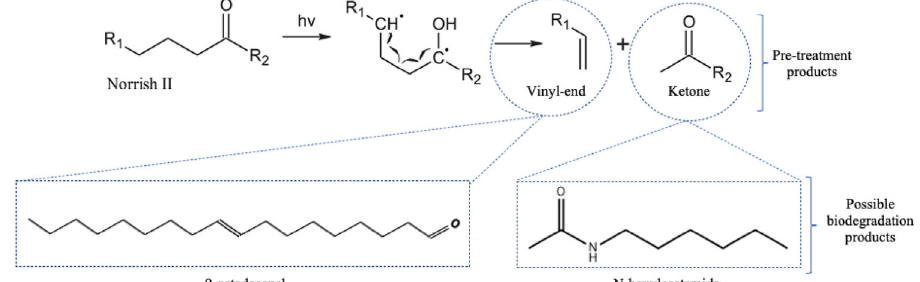
Fig. 4 Potential mechanism of ketone and double bond-end group formation through Norrish type II mechanism 11,36 . Pre-treatments employed produce long chain fragments with methyl ketone and vinyl-end groups. Post-degradation with fungi, it is expected that low molecular weight compounds such as 9-octadecenal to be produced, proving the aid of pre-treatment to ease fungal